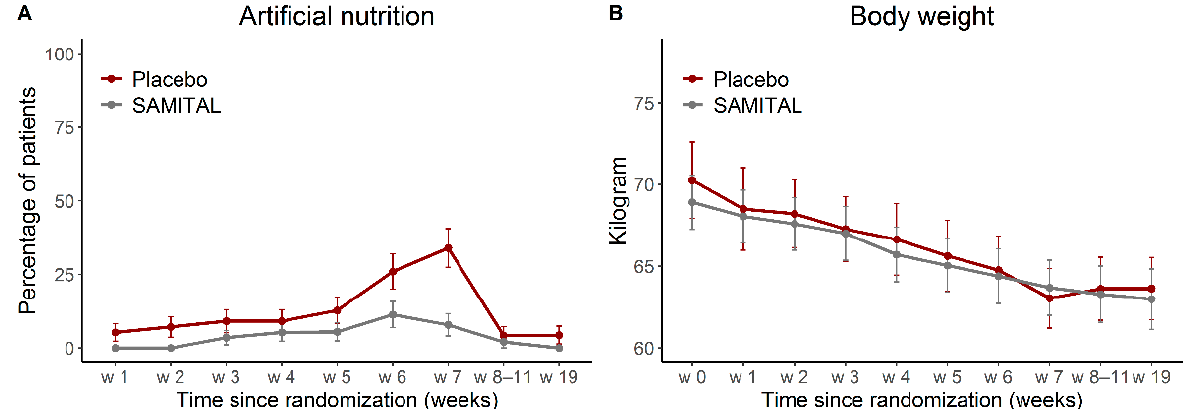
Figure 4. ( A ) Use of artificial nutrition and ( B ) body weight over time. Data are presented as estimated values at every time point, together with their 95% confidence interval.